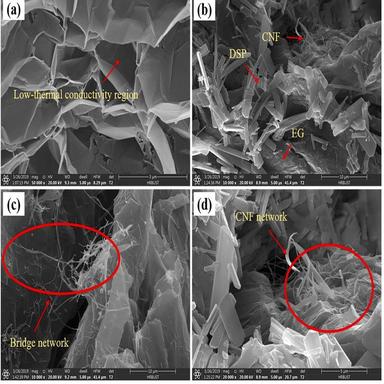
SEM images of (a) pure expanded graphite, (b) the DSP/CNF-EG composite, (c) thermal bridge network of CNF and (d) thermal network of CNF . Reproduced with the permission of IOP Publishing.